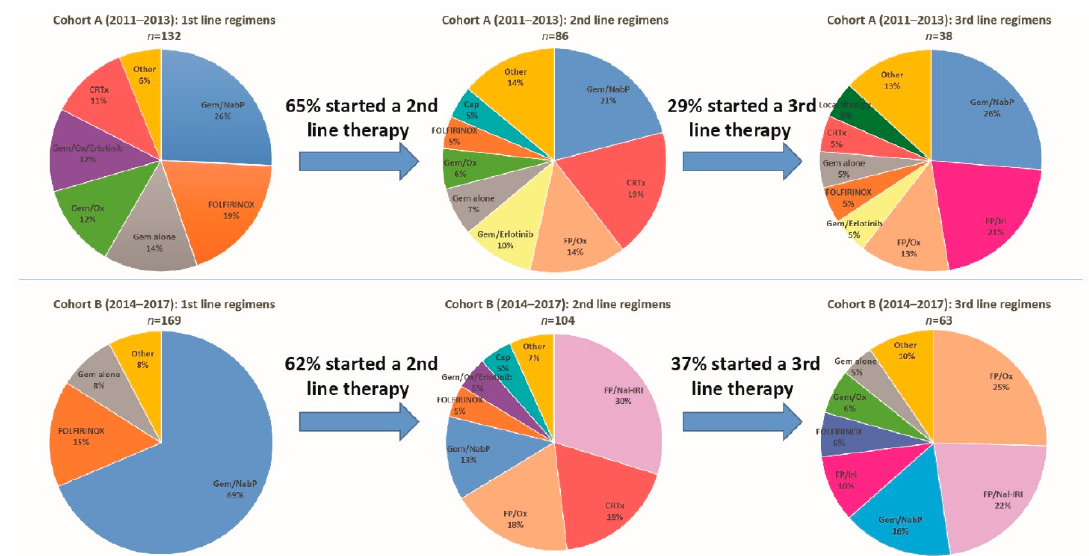
Figure 1. Treatment patterns. Treatment regimens from first to third line of locally advanced or metastatic patients who started a systemic treatment between 2011–2013 and 2014–2017.